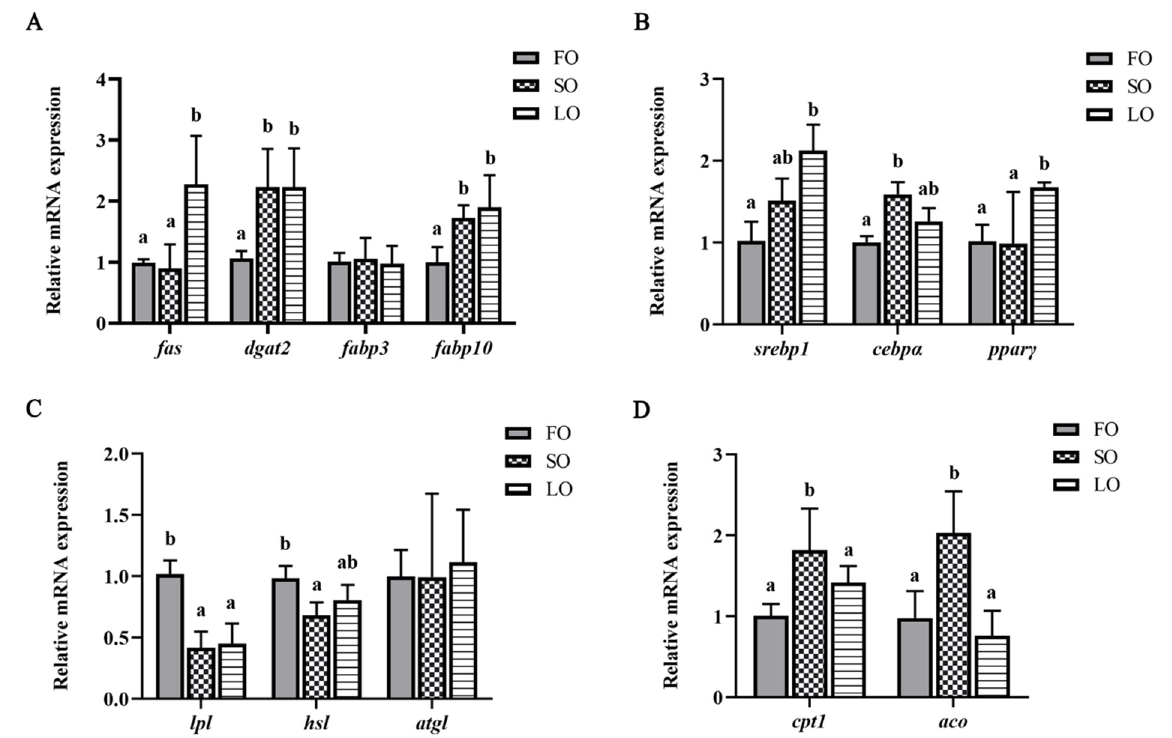
Figure 3. Effects of dietary SO and LO on the gene expressions related to lipid metabolism in adipose tissue of large yellow croaker. ( A , B ) Lipogenesis and fatty acid transport; ( C ) lipolysis; ( D ) fatty acid β -oxidation. Results are presented as the means ± S.E.M. and were analyzed using Tukey’s test (n = 4). Bars labeled with the same letters are not significantly different ( p > 0.05; no difference between the unlabeled bars).